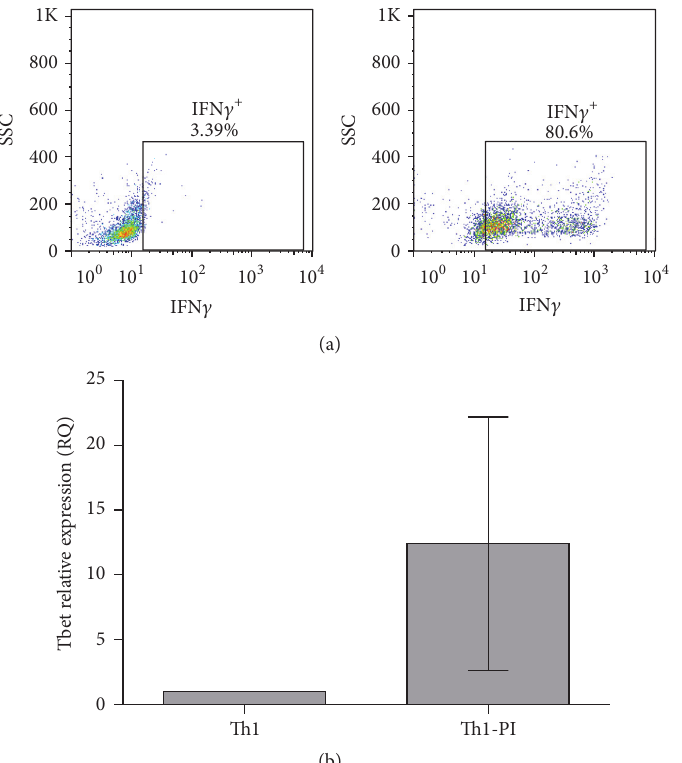
Figure 1: Assessment of Th1 polarisation. (a) Flow cytometry dot plots represent the IFN 𝛾 production against the size scatter of Th1-polarised cells without (Th1) or with PI treatment (Th1-PI). The percentage of IFN 𝛾 producing cells is indicated. A representative experiment is shown. (b) Determination of the RQ of the transcription factor Tbet in na¨ıve and Th1 cells. The average and the standard deviations of 3 donors are